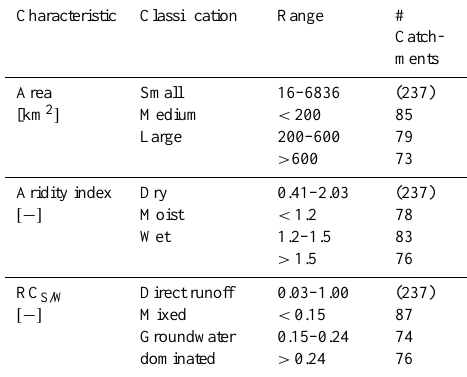
Table 2. Catchment characteristics and number of catchments in each classification range. Classifications are valid for the 237 French catchments used in this